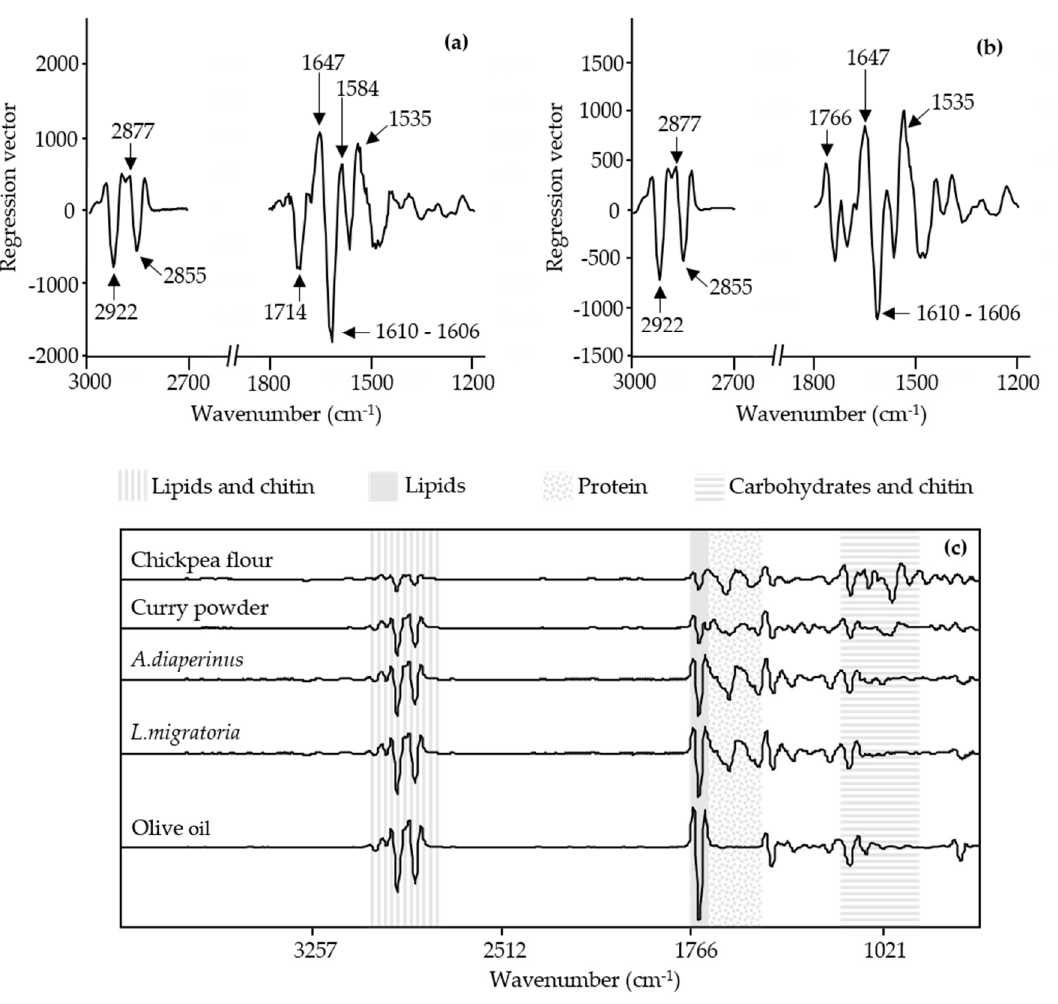
Figure 12. PLSR regression vector plot of FTIR spectroscopy spectra (3000–2700 cm − 1 and 1800–1200 cm − 1 ) from an ( a ) A. diaperinus dough prediction model, ( b ) L. migratoria dough prediction model, and ( c ) the transformed spectra (vector length normalized and transformed using second derivative polynomial-fit Sa-vitzky–Golay function (13 points)) of the raw ingredients used for the dough preparation.